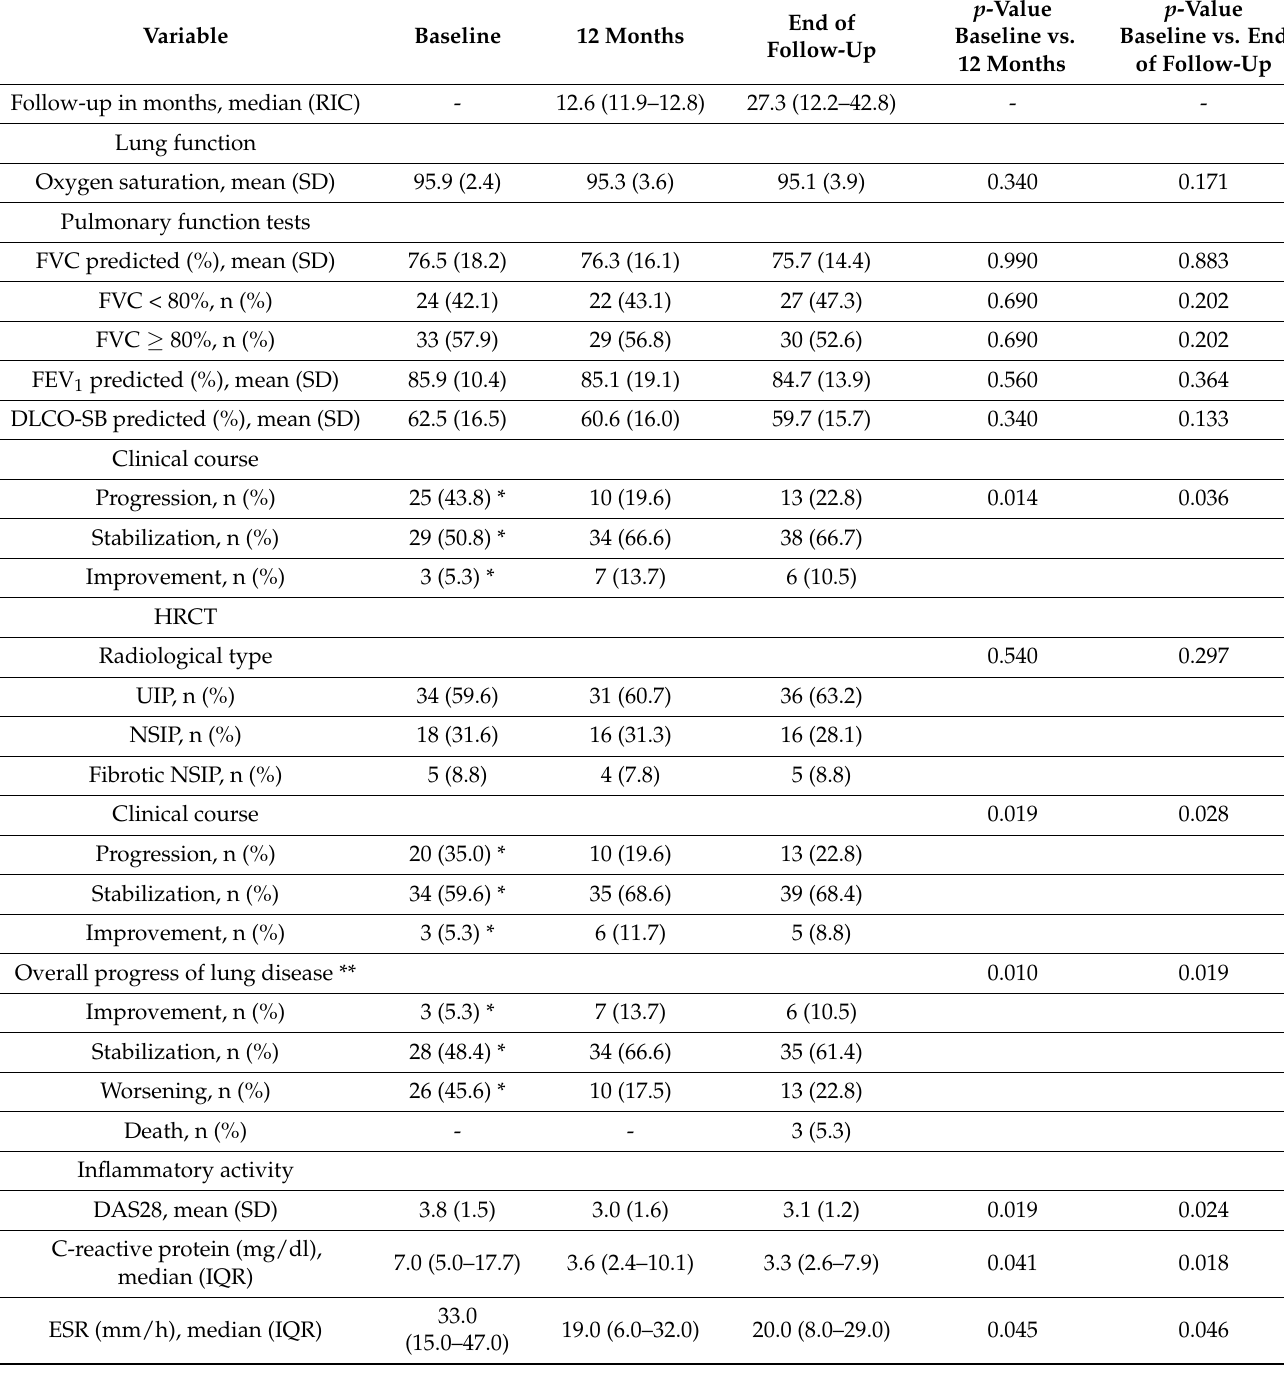
Table 2. Progress of symptoms and lung disease at the end of follow-up in 57 patients with RA-ILD treated with